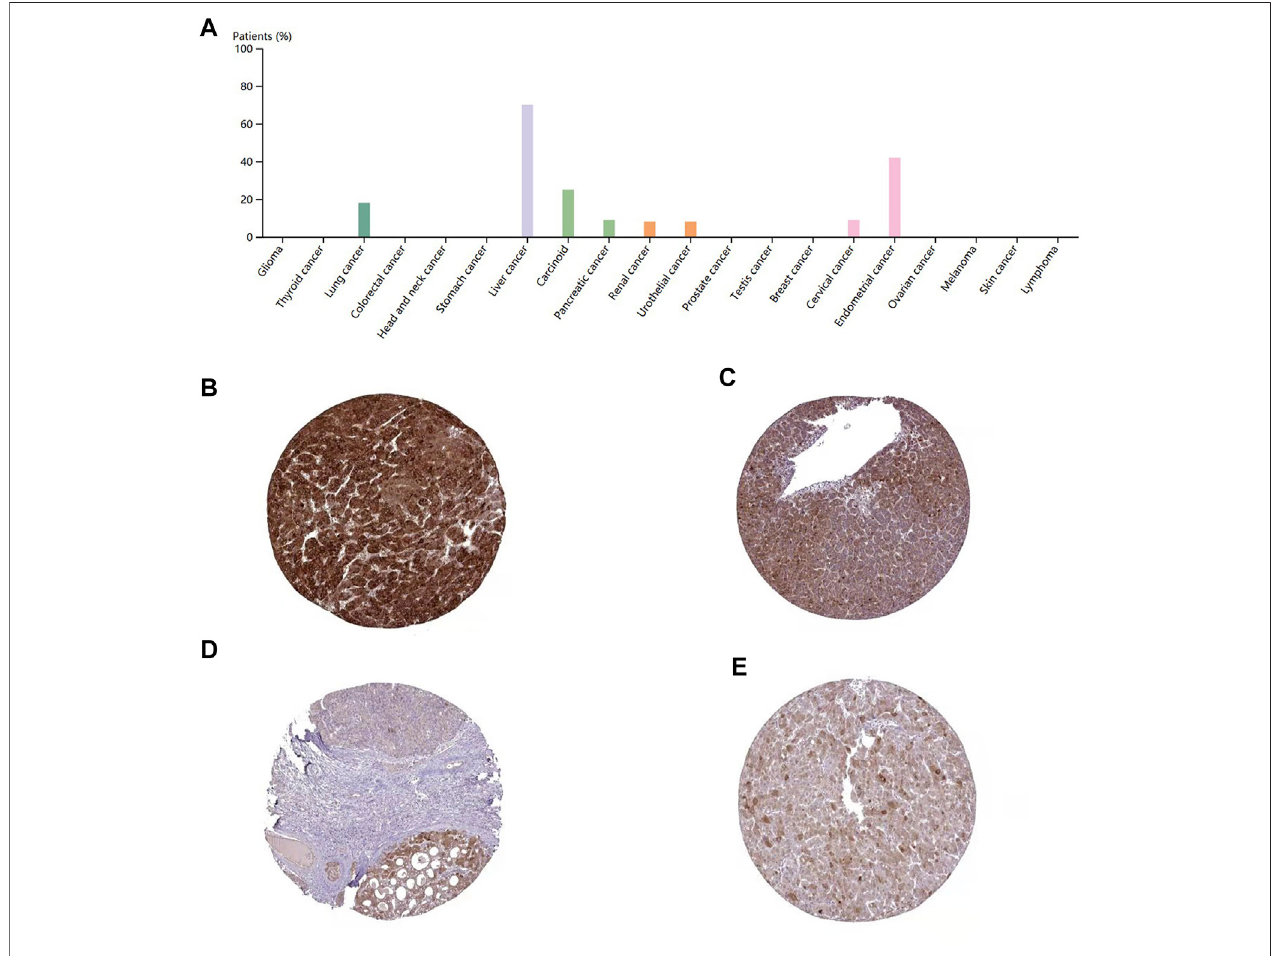
FIGURE 6 | immunohistochemistry of DEPDC1B in various types of cancer (A) and LIHC tissues (B – E) using HPA072558 antibody. (A) Strong cytoplasmic positivity was displayed in several hepatocellular carcinomas and single cases of carcinoma and urothelial cancer. Several endometrial cancers and a few other cancer tissues showed moderate immunoreactivity. The remaining cancer tissues were weakly stained or negative. Tumor cells staining: high expression (B,C) and medium expression (D,E) ; (B) Patientid:3,477,male,age67; (C) :Patientid:5,032,female,age58; (D) Patientid:3,196,male,age65; (E) Patientid:4,823,female,age25. DEPDC1B was mainly stained in the cytoplasmic/membranous LIHC cells using HPA072558 antibody (Atlas Antibodies Sigma-Aldrich).